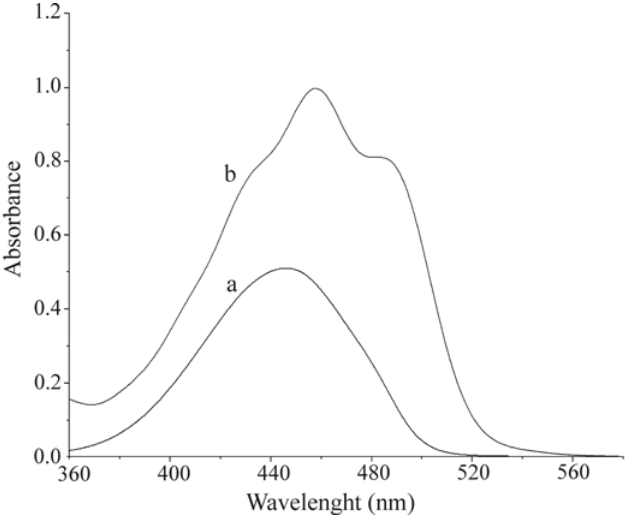
Fig. 2 - RNO (a) and ß-carotene (b) absorbance spectra. Aqueous solution of ß-carotene was prepared as reported in Methods. Absorbance spectra of 15 µM RNO (trace a) and 8 µM ß-carotene (trace b) were recorded in 2 mL of 100 mM sodium borate buffer pH